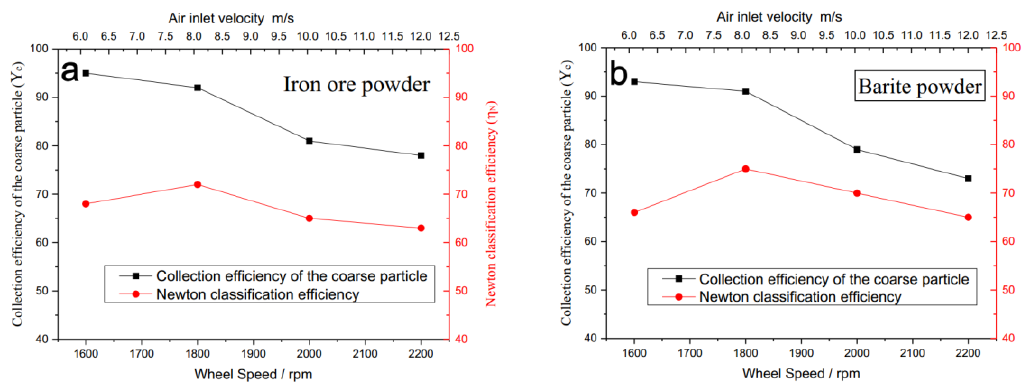
Figure 8. E ff ects of four process parameters on two di ff erent materials of the coarse powder yield ( Y c ) Figure 8. Effects of four process parameters on two different materials of the coarse powder yield ( Y c ) and Newton e ffi ciency ( η N ). ( a ) Iron ore powder ( b ) Barite and Newton efficiency ( ).(a)Iron ore powder (b) Barite powder